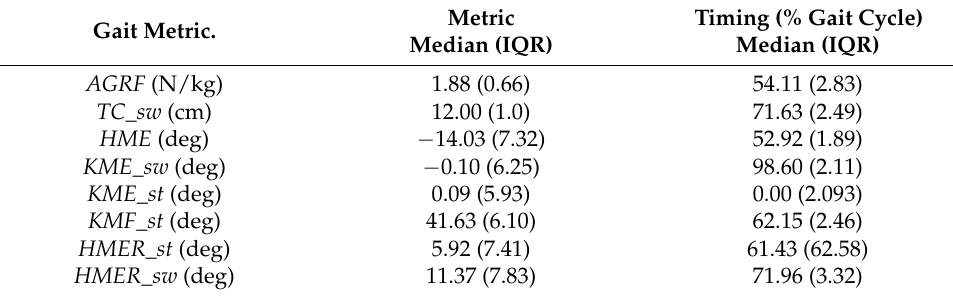
Table 3. TD gait metrics and timing of gait metrics. Gait